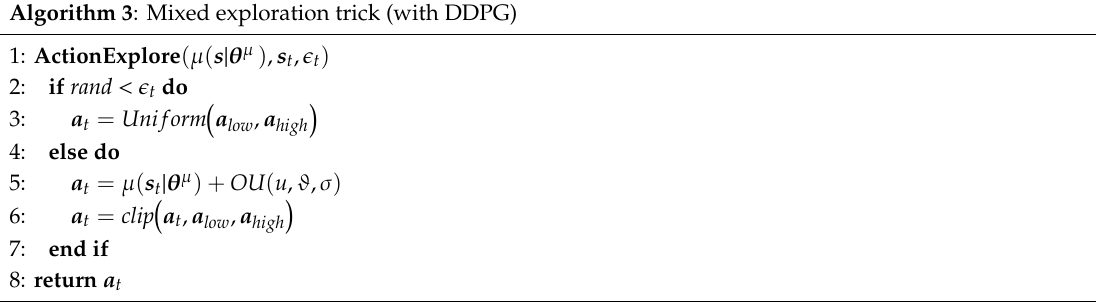
Algorithm 3 : Mixed exploration trick (with